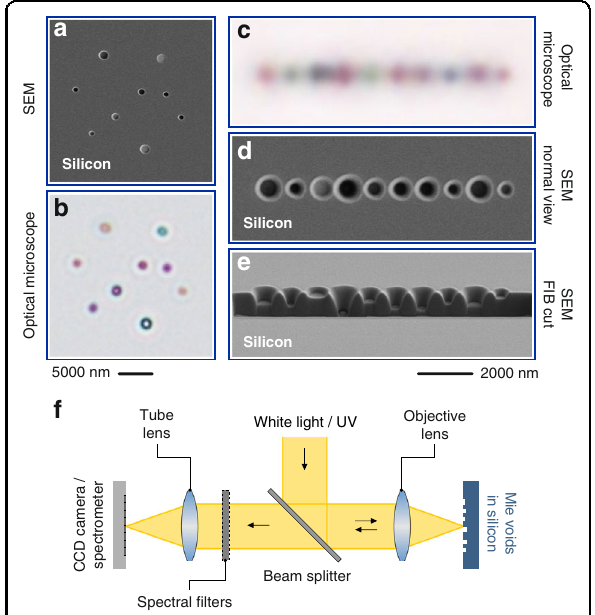
Fig. 1 Resonant dielectric Mie voids. Focused ion beam milling allows to structure conically shaped voids of varying diameter and depth into a bulk silicon wafer. a The scanning electron microscopy (SEM) image shows a random arrangement of holes of varying diameter and depth. b In the optical microscope image one can observe the wavelength-dependent resonant scattering from the individual voids. Evidently, diameter and depth contribute to the resonant behaviour. The same behaviour is observed for the chain of voids with 900 nm distance with varying size and depth. c Optical microscope image. d Top view SEM image, e Tilted SEM image of a focused ion beam cut. The distinct colour impression of each void can clearly be resolved in the optical microscope image. These experiments underpin the resonant and localized nature of the observed modes, which depend both on depth and diameter (or volume). f Sketch of the experimental setups used. The surface of the silicon is illuminated with white light and the re fl ected light is collected. The setups allow to control the angle of incidence via apertures. Additionally, spectral fi lters (band pass fi lters) allow